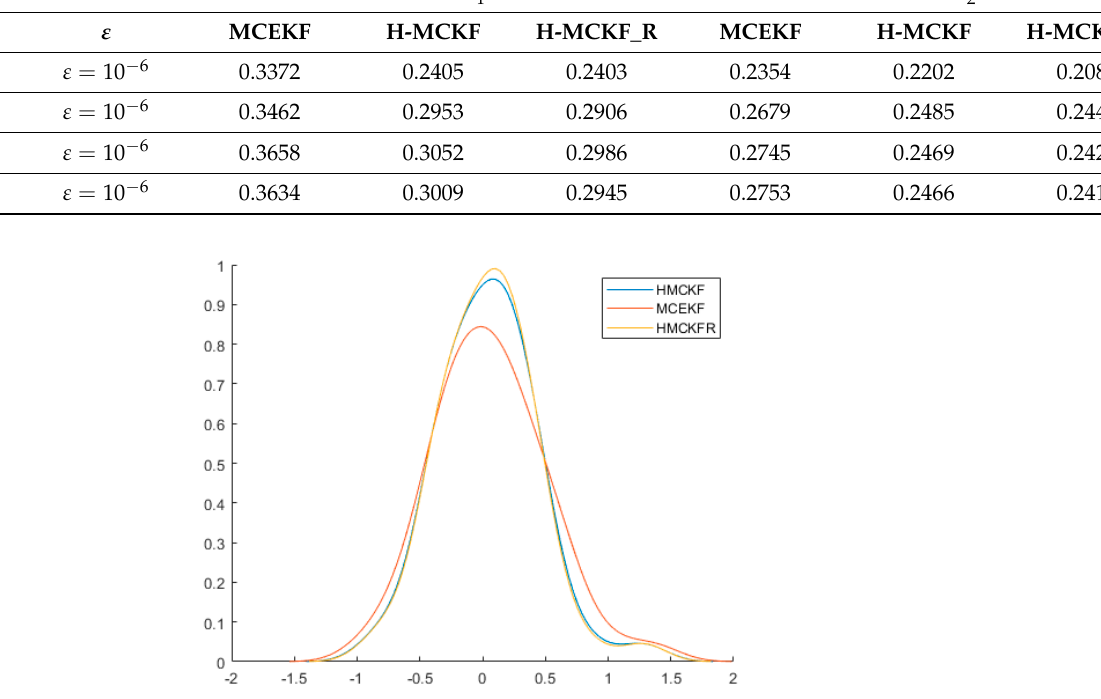
Figure 4. Probability densities of x 1 estimation errors with the three filters in case 1.